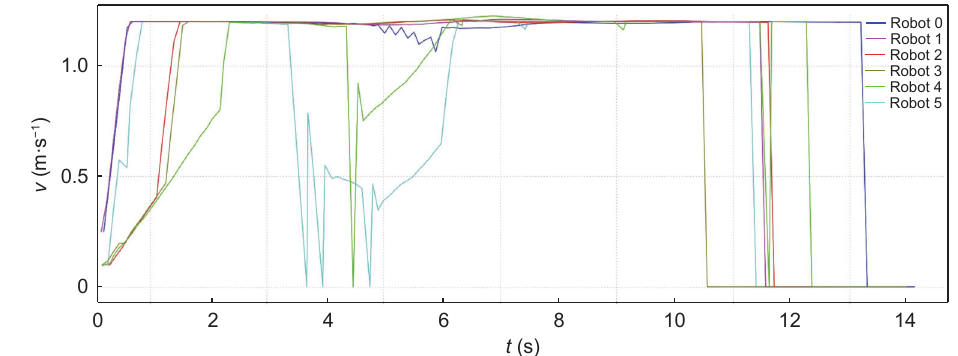
Fig. 19 Velocity evolution by using the proposed D-MPCC